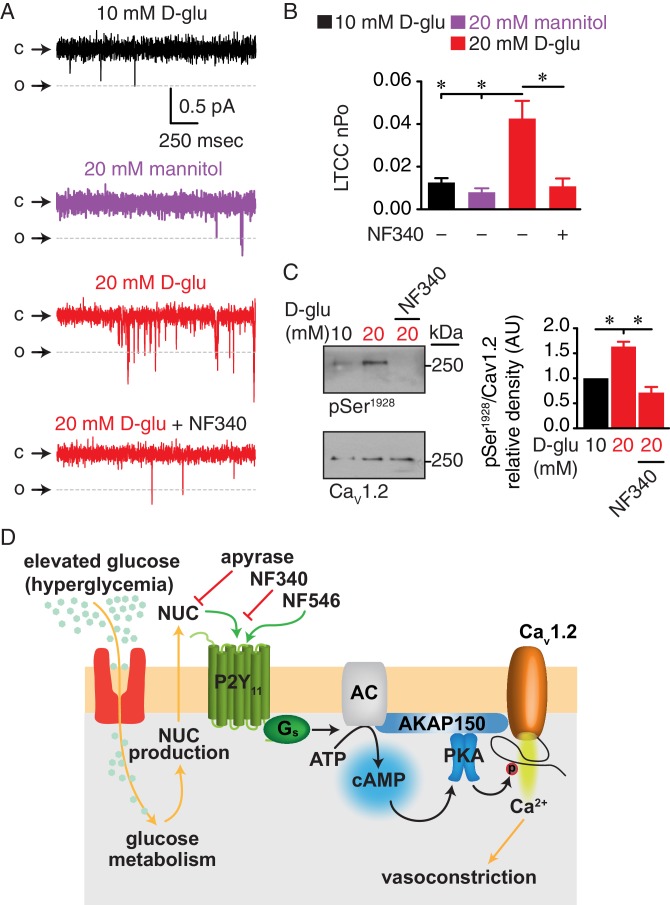
Augmented LTCC activity and Ser1928 phosphorylation in response to chronic extracellular glucose elevations are prevented in the presence of the P2Y11 antagonist NF340.(A) Representative single LTCC recordings obtained during a 2 s step depolarization from −80 to −30 mV and (B) bar plot of LTCC nPo in arterial myocytes isolated from mouse cerebral arteries incubated for 48 hr in 10 mM D-glucose (n = 10 cells from three mice), 20 mM mannitol (n = 13 cells from four mice), 20 mM D-glucose (n = 10 cells from four mice) and 20 mM D-glucose +10 µM NF340 (n = 10 cells from four mice). Channel openings (o) are represented by downward deflections from baseline (c) (*p<0.05, one-way ANOVA with Tukey post hoc test; Figure 8—source data 1). (C) Representative immunoblot detection of phosphorylated Ser1928 (pSer1928) and total CaV1.2 from mouse cerebral and mesenteric arteries incubated for 48 hr in 10 mM D-glucose, 20 mM D-glucose and 20 mM D-glucose +10 µM NF340 and densitometry quantification of pSer1928/CaV1.2 ratio (n = 7 arterial lysates per condition) (*p<0.05, Kruskal-Wallis with Dunn’s multiple comparisons; Figure 8—source data 2). (D) Proposed model for the role of P2Y11 in PKA-dependent stimulation of LTCC activity and vasoconstriction during diabetic hyperglycemia (NUC = nucleotides).10.7554/eLife.42214.066Figure 8—source data 1.Excel spreadsheet containing the individual numeric values of LTCC nPo analyzed in Figure 8B.10.7554/eLife.42214.067Figure 8—source data 2.Excel spreadsheet containing the individual numeric values of pSer1928/CaV1.2 relative density analyzed in Figure 8C.